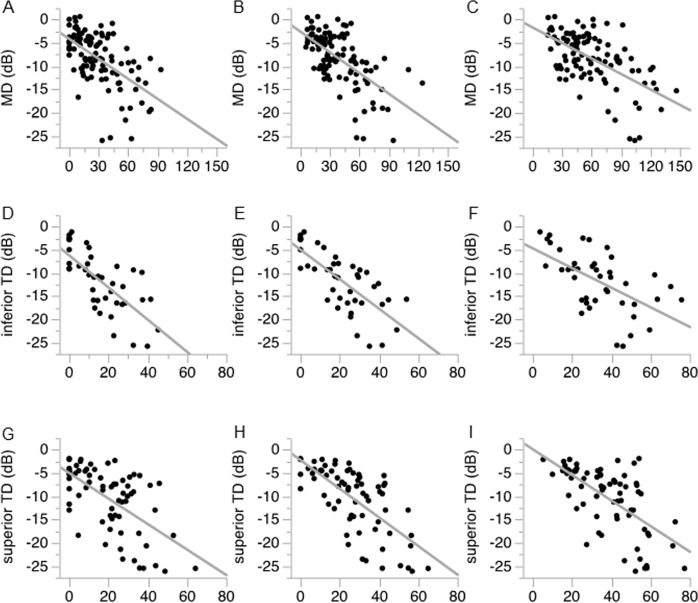
Association between RNFLD angle and the visual field.Scatter plot showing the correlation coefficient between RNLDA and HFA MD in the en-face image 1 (A), en-face image 2 (B), and en-face image 3 (C). (D-F) Correlation between RNFLDA and inferior TD. (G-I) Correlation between RNFLDA and superior TD.